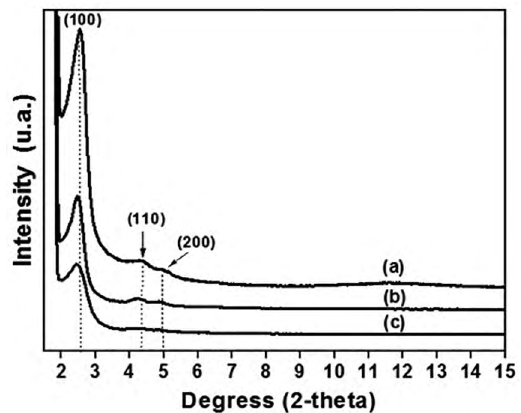
Figure 1. XRD patterns of samples of (a) MCM-41, (b) Al- MCM-41(50), (c) Al-MCM-41(15).